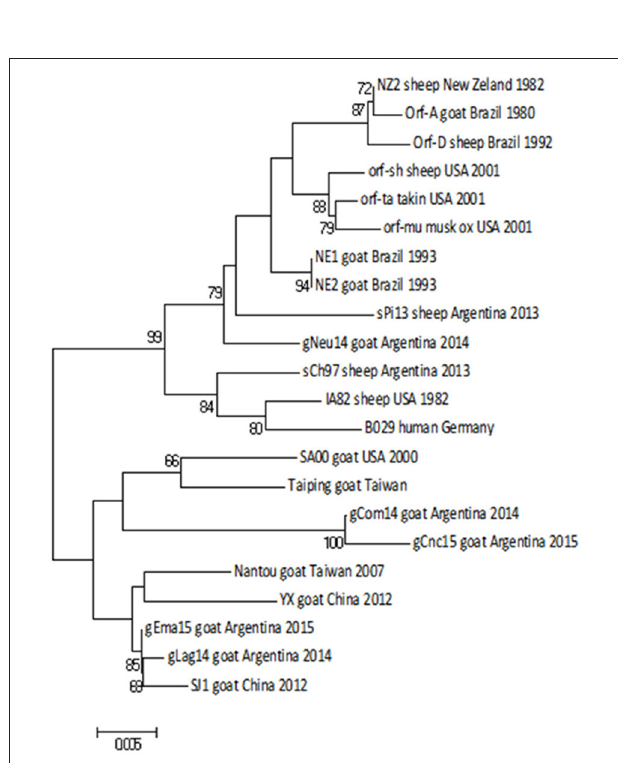
FIGURE 5 | Phylogenetic analysis based on nucleotide sequence of orf020 . The phylogenetic relationship was constructed by the Neighbor-Joining algorithm using MEGA 6.0 software. Numbers at nodes represent % of one thousand bootstrap replicates. The scale bars are expressed in relative nucleotide sequence